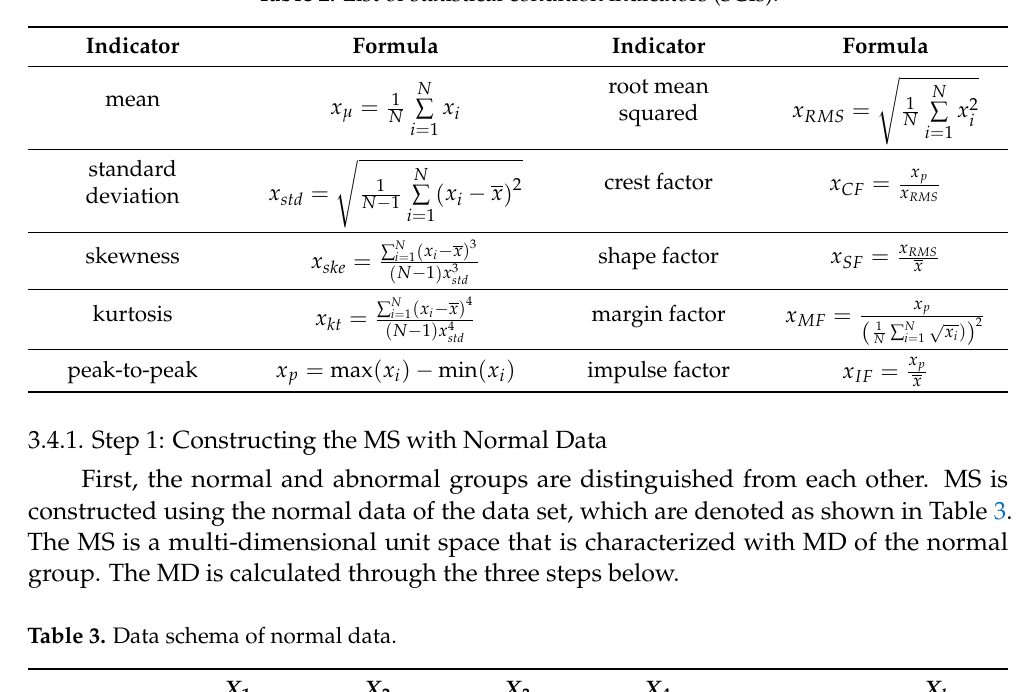
Table 2. List of statistical condition indicators (SCIs).